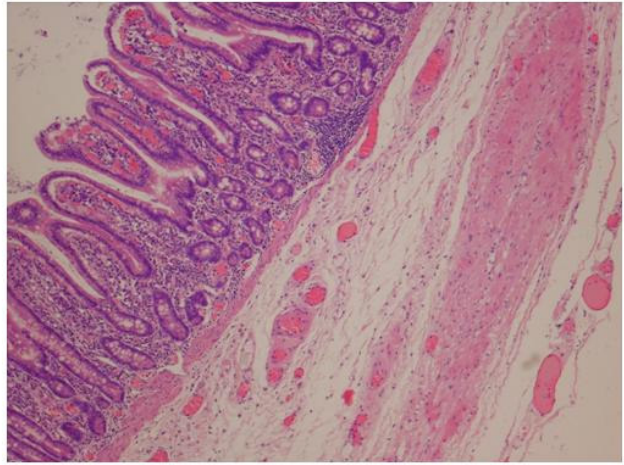
FIGURE 7. Low-power ( × 40) photomicrograph of a jejunal diverticulum showing all the layers of small bowel, namely mucosa, submucosa, muscular layer, and serosa. There is no sign of